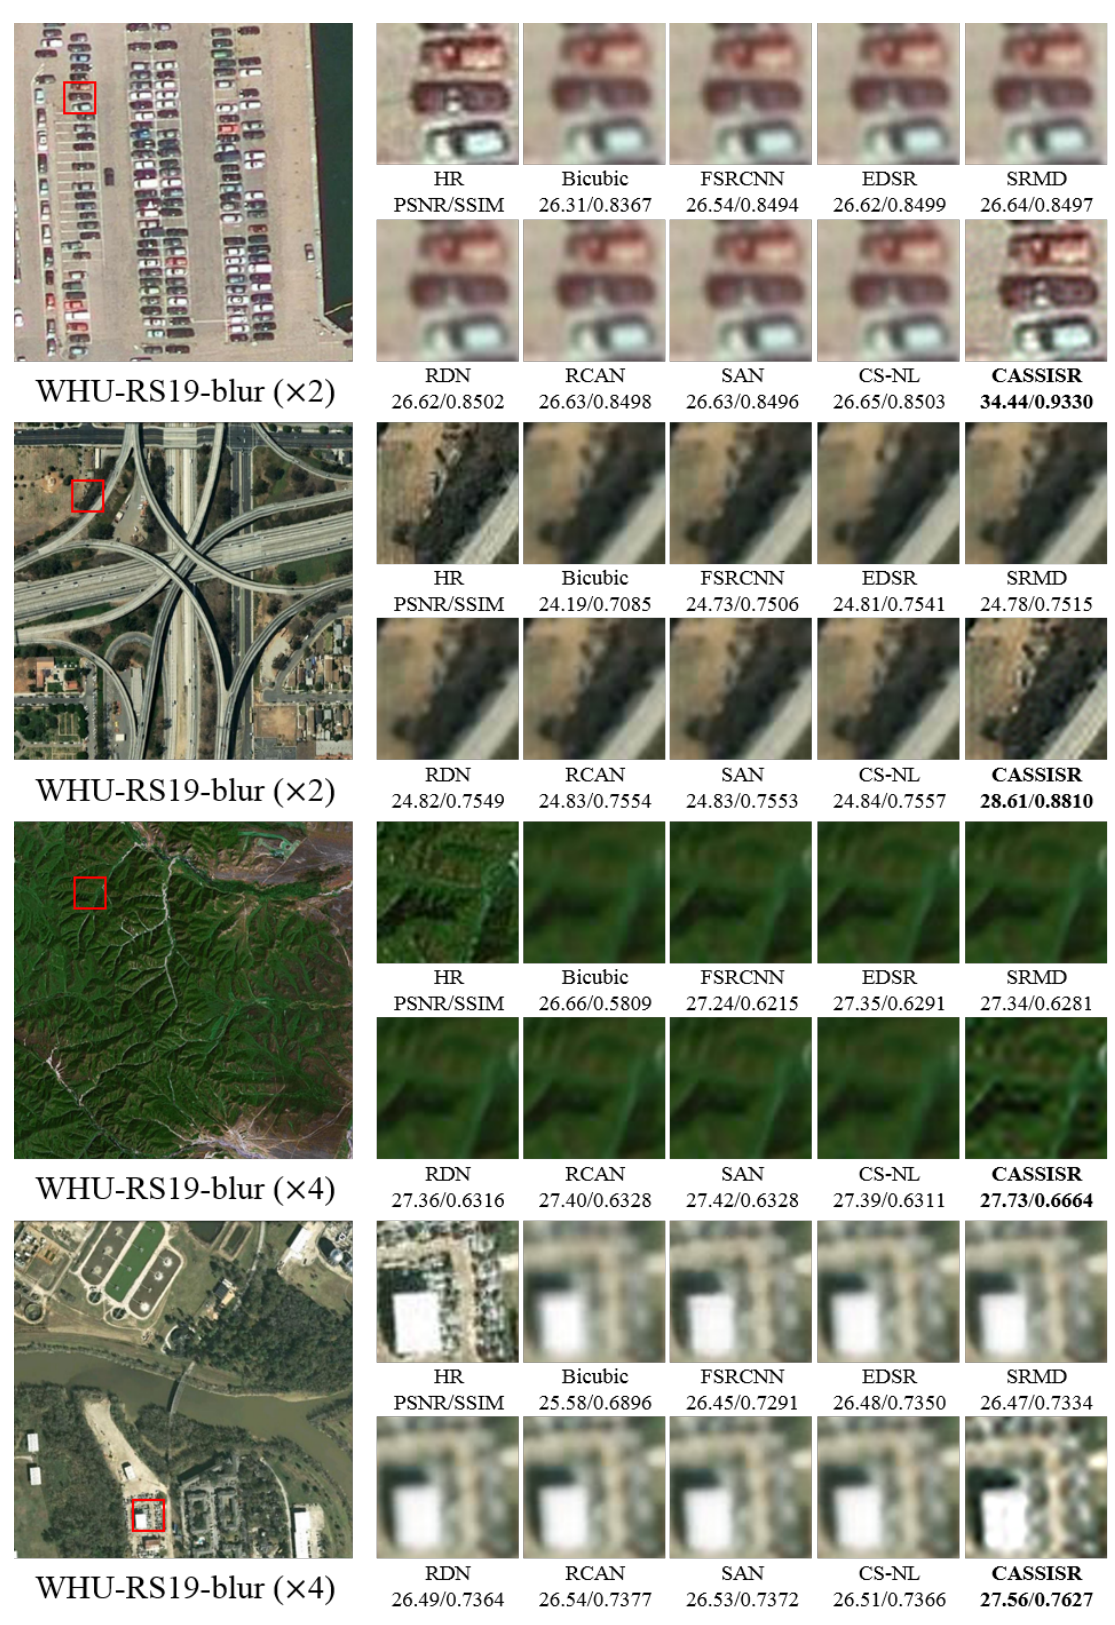
Figure 6. Qualitative comparison of scaling factors × 2 and × 4 between CASSISR and CNN-based SR methods on WHU- RS19-blur dataset. Our CASSISR results are highlighted